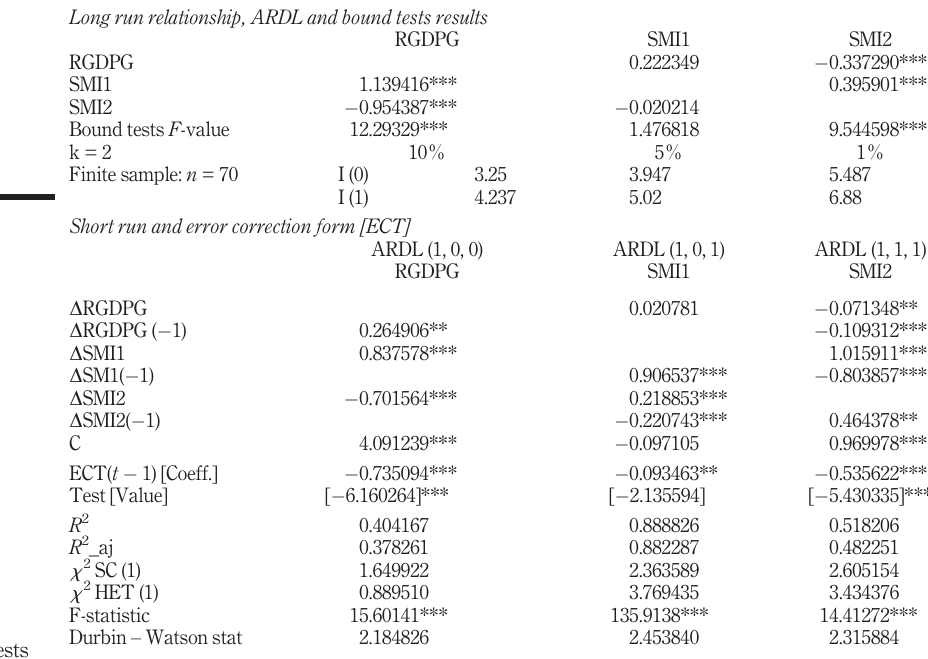
Table 6. ARDL bound tests and ECT for RGDPG, SMI1 and